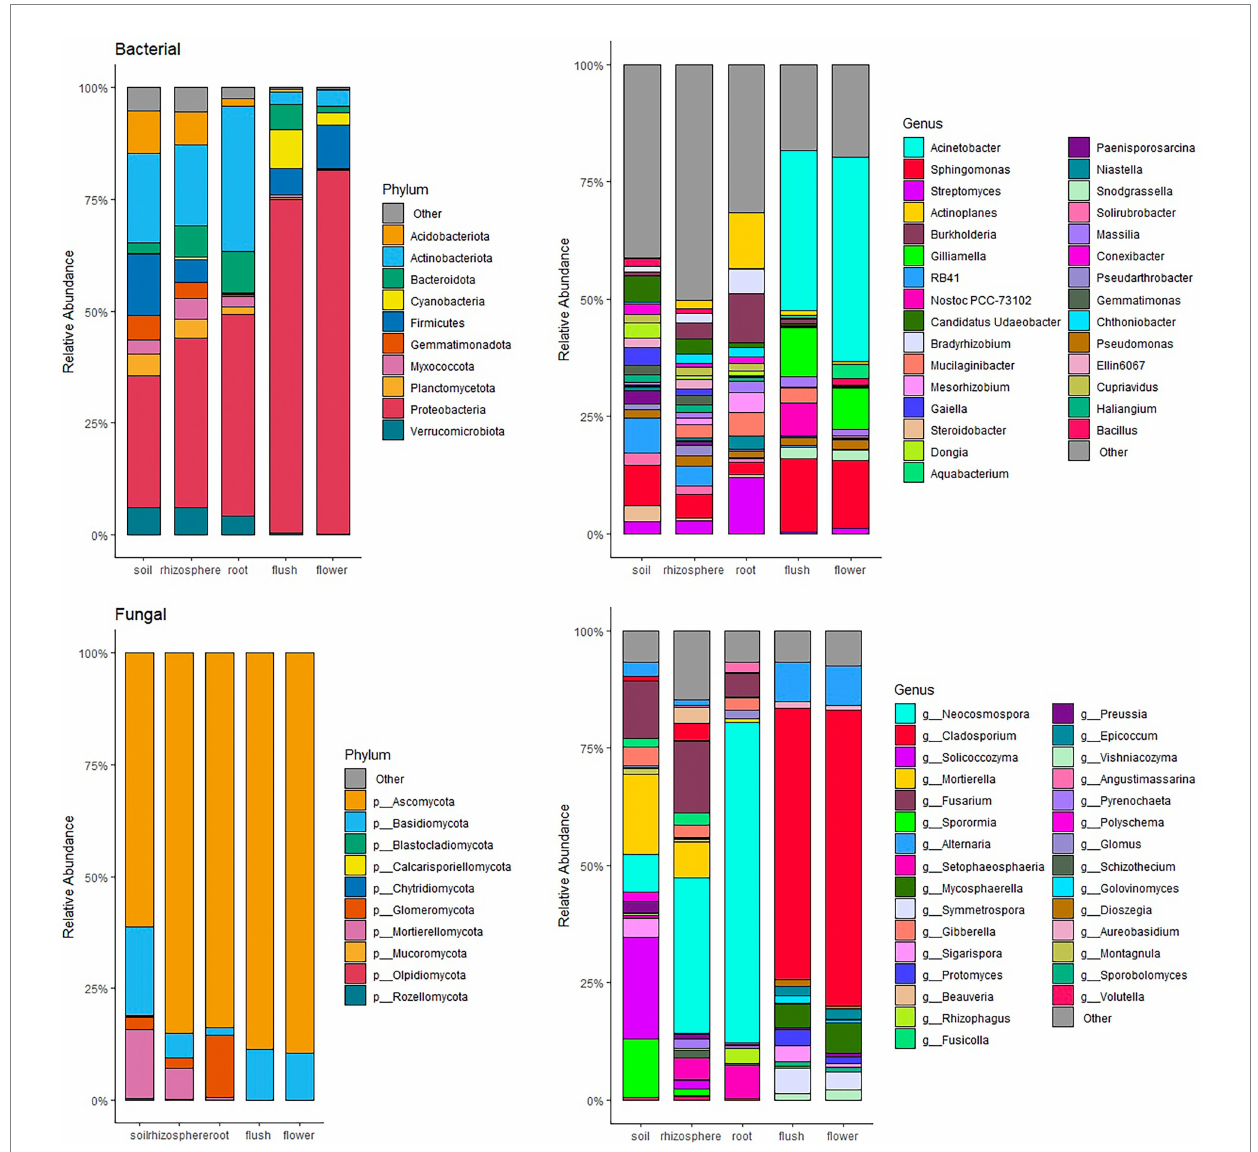
FIGURE 3 Relative abundant bar chat of bacteria (top panels) and fungi (bottom panels) community at phylum (left panels) and genus (right panels) level within individual citrus biocompartment (soil, rhizosphere, root, flush and flower). Only top 10 phyla and top 30 genera occurring at ≥ 1% relative abundance are